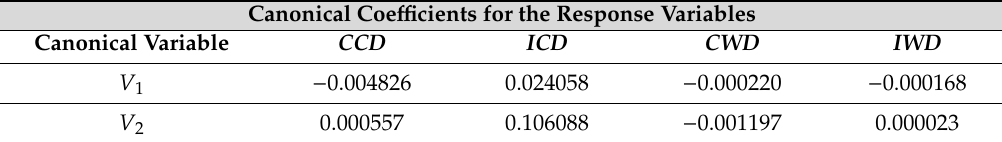
Table 4. The canonical coe ffi cients for CCD, ICD, CWD , and IWD in terms of V 1 , V 2